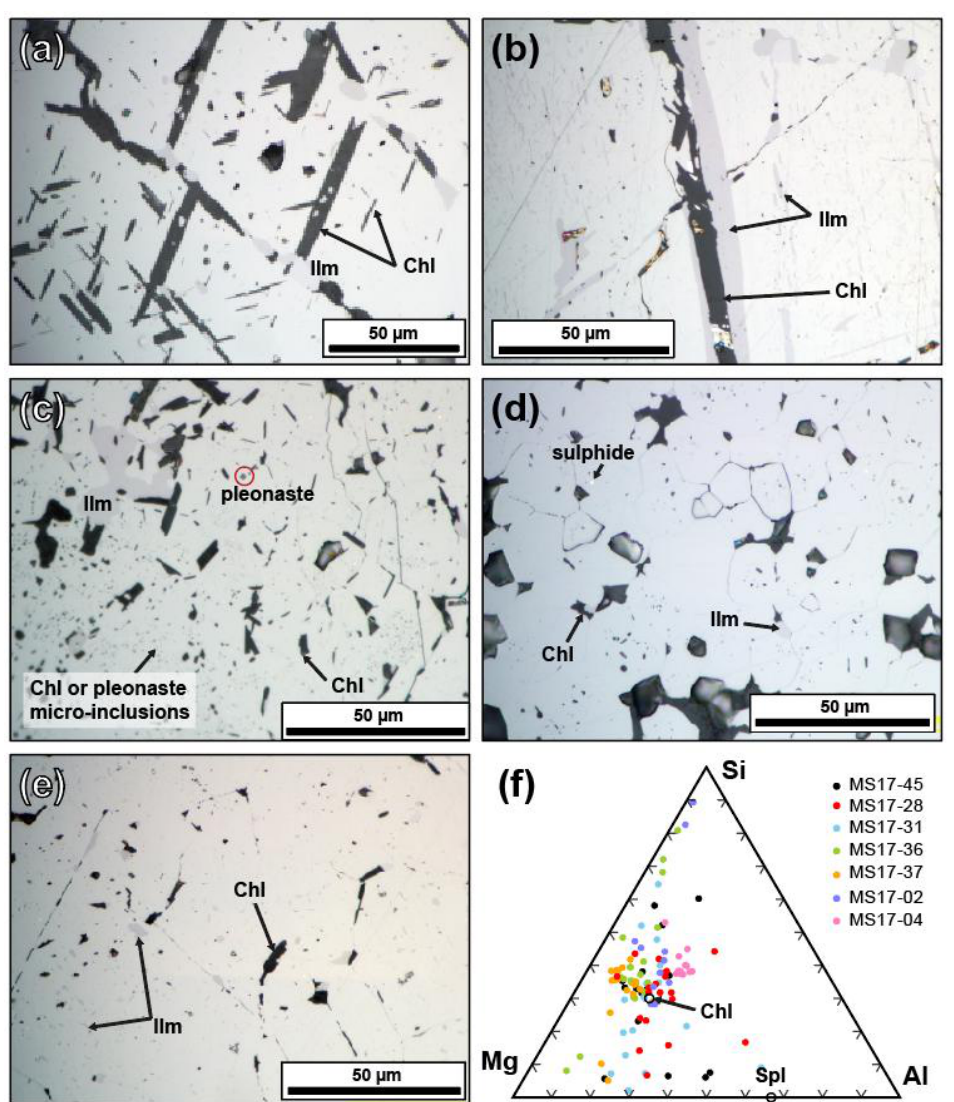
Figure 8. Reflected light images showing magnetite textures in samples: ( a ) MS17-31 (rectilinear chlorite inclusions controlled by the crystallography of the magnetite); ( b ) MS17-28 (thick chlorite inclusion and ilmenite lamellae—note the absence of inclusions and exsolutions in the immediate vicinity of these minerals); ( c ) MS17-02 (rectilinear chlorite inclusions, granular ilmenite exsolutions, and micro-inclusions of chlorite and/or pleonaste); ( d ) MS17-04 (size-reduced magnetite grains with well-developed triple-junctions and granular ilmenite exsolutions); ( e ) MS17-36 (rectilinear and globular chlorite inclusions and granular ilmenite exsolutions – note the abundance of chlorite and/or pleonaste micro-inclusions). ( f ) Magnetite analyzed by LA-ICP-MS (n = 114) displayed on a Si-Mg-Al (molar) ternary diagram, indicating that the inclusions and micro-inclusions are chlorite, ± other silicates and ± pleonaste. Mineral abbreviations are as reported in the literature [34].